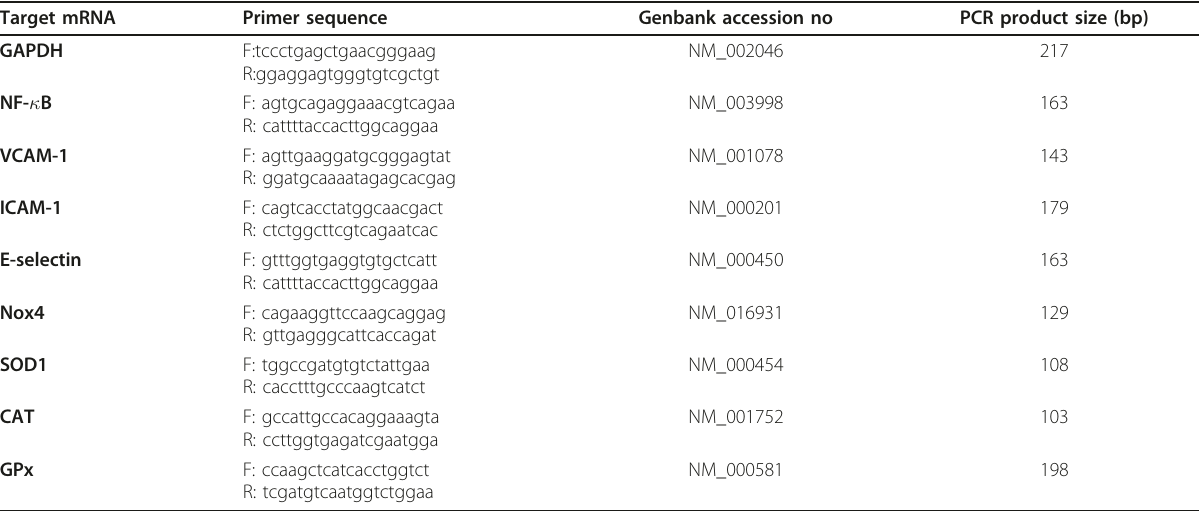
Table 1 List of primers for qPCR analysis Target